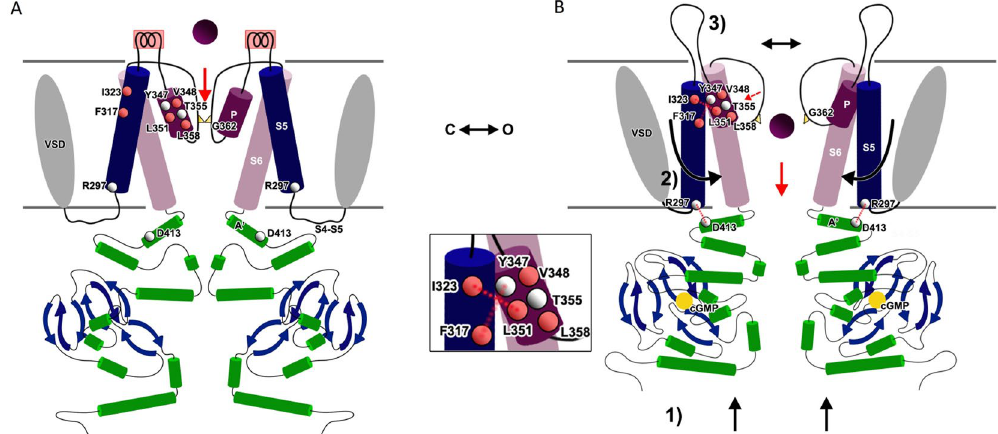
Figure 8. Proposed gating mechanism. ( A , B ) Cartoon representation of the proposed gating mechanism of CNGA1 from the closed state ( A ) to the open state ( B ). Before the binding of CNs, the CNBD is unstructured and D413 and R297 do not interact ( A ). Upon CNs binding the CNBDs change their conformation and move toward the transmembrane domain (1). The C-linker is then pushed toward the channel core. The interaction between R297 in the intracellular part of S5 transmembrane domain and D413 in the C-linker causes the motion of S5 so that the P-helix can interact with S5 (2). Opening of the gate at the selectivity filter (3). Sequence tracts from S4-S5 to S5 are coloured in blue, S6 in pink, P helices are coloured in magenta. Key residues are highlighted: hydrophobic residues are coloured in red, other residues are